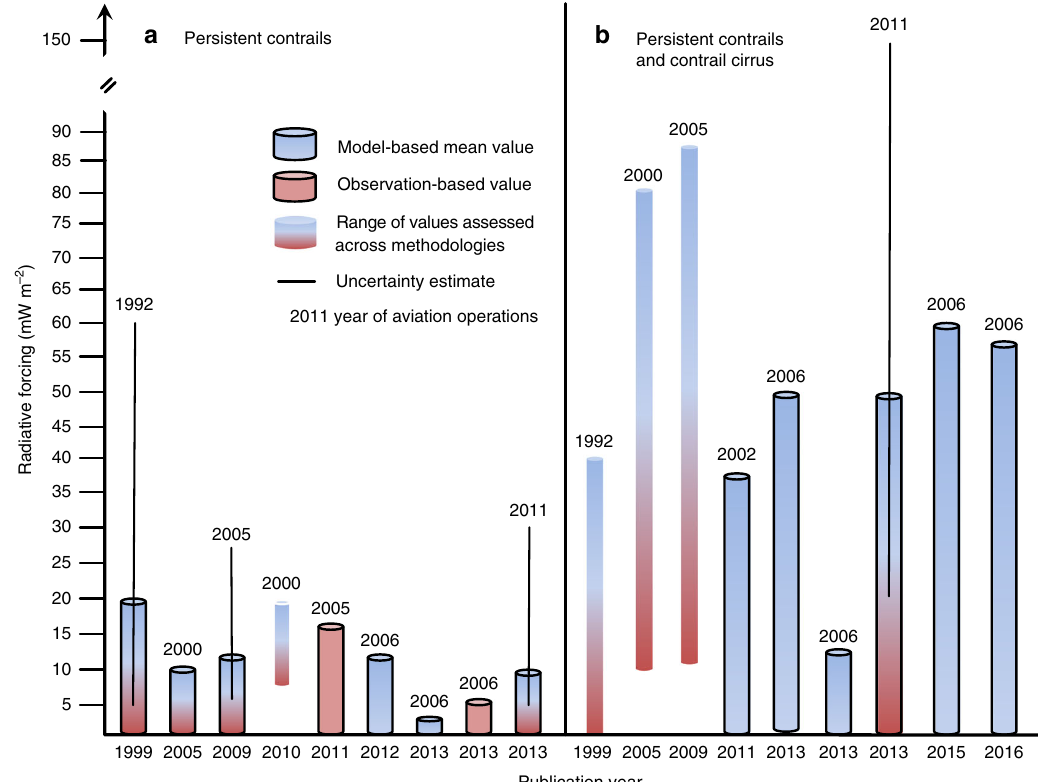
Fig. 7 Global annual mean radiative forcing due to aircraft-induced clouds. RF due to a persistent contrails alone and b together with contrail cirrus from selected studies and assessments sorted by publication date since 1999. Purely observational global estimates derive from extrapolating local aircraft and regional satellite data. Pure model estimates are based on or rely upon global model simulations. Uncertainty ranges evaluated across several methodologies are taken from comprehensive assessments. IPCC 1999 assessed persistent contrail RF to be 20 (5 – 60) mW m − 2 for air traf fi c in the